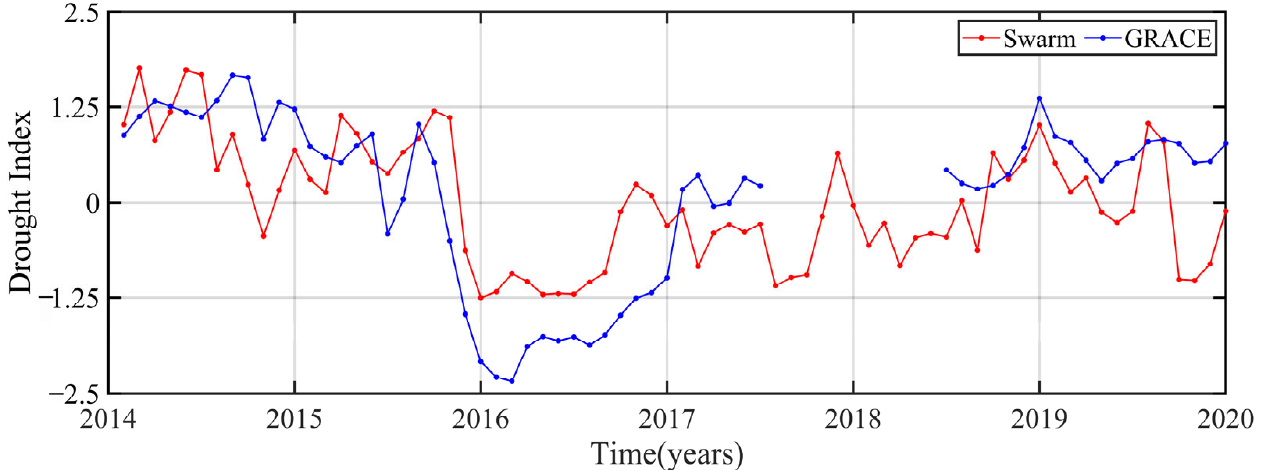
Figure 6. The time series of drought indices form GRACE and Swarm models in the ARB from 2014 to 2019.